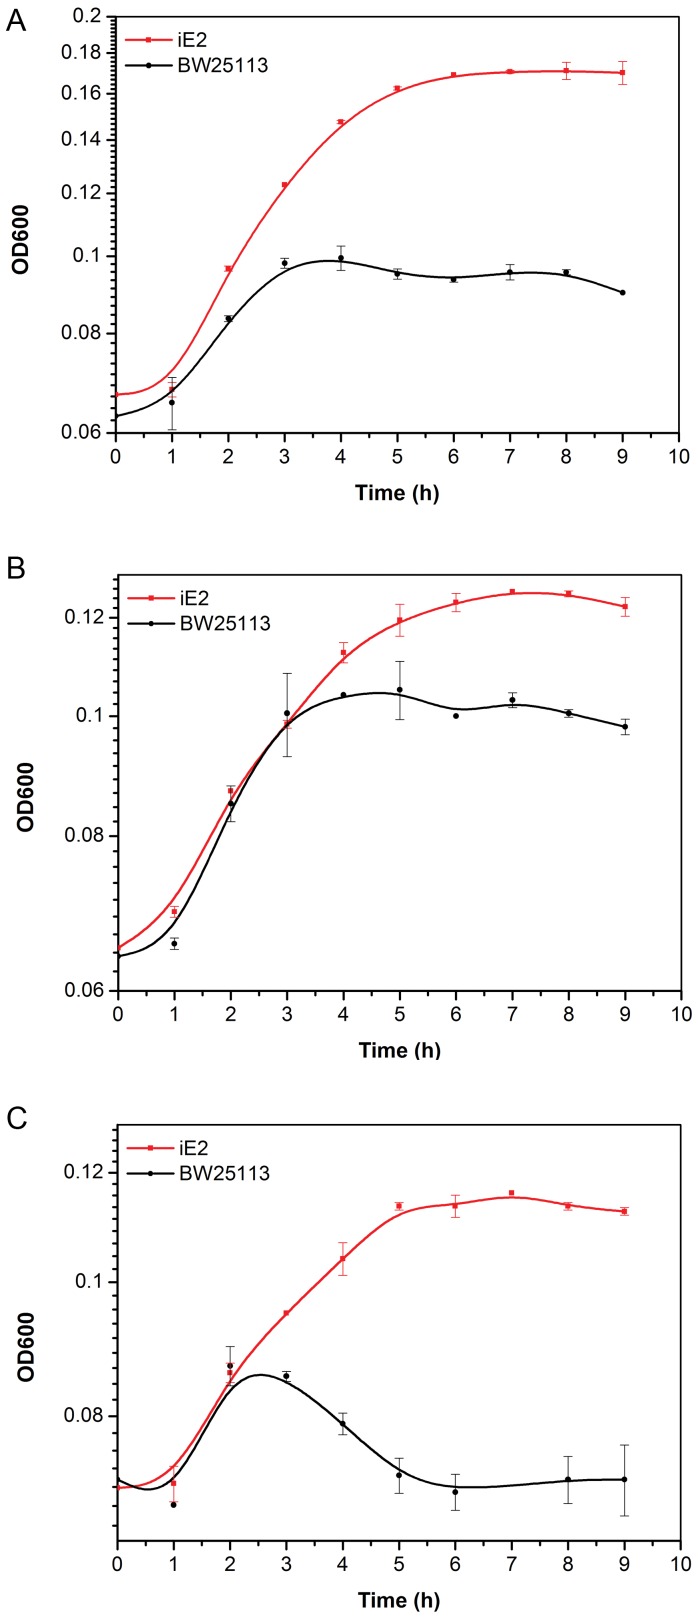
iE2 tolerance towards other alcohols as compared to parent strain BW25113.Cells were cultivated at 37°C in LB medium containing different alcohols: (A) 3.1% (v/v) 1-propanol, (B) 1.3% (v/v) 1-butanol, (C) 0.45% (v/v) 1-pentanol.